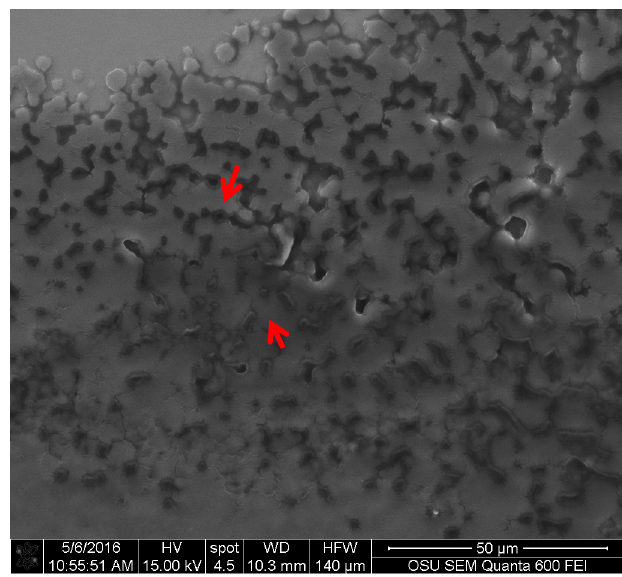
Figure 6. Extracted pigment of S. ganodermophthorum showing texture. Different electron reflectance is indicated with arrows. Picture taken with an FEI QUANTA 600 F.